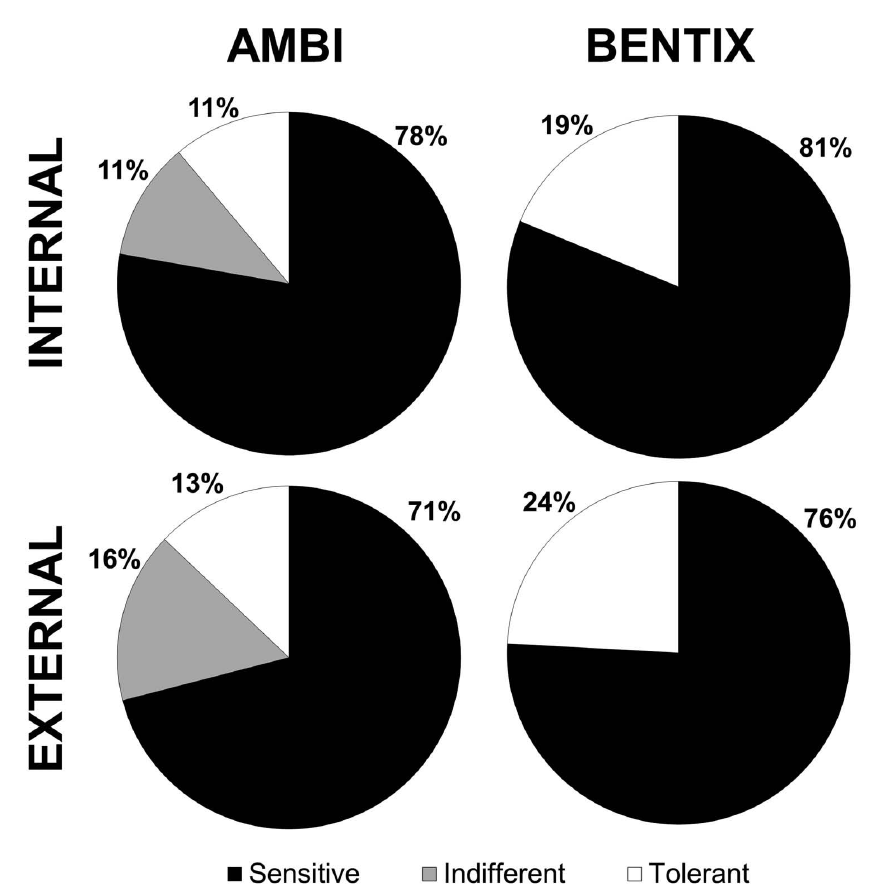
Fig. 6. – Percentage of species belonging to ecological groups in function of their tolerance to environmental